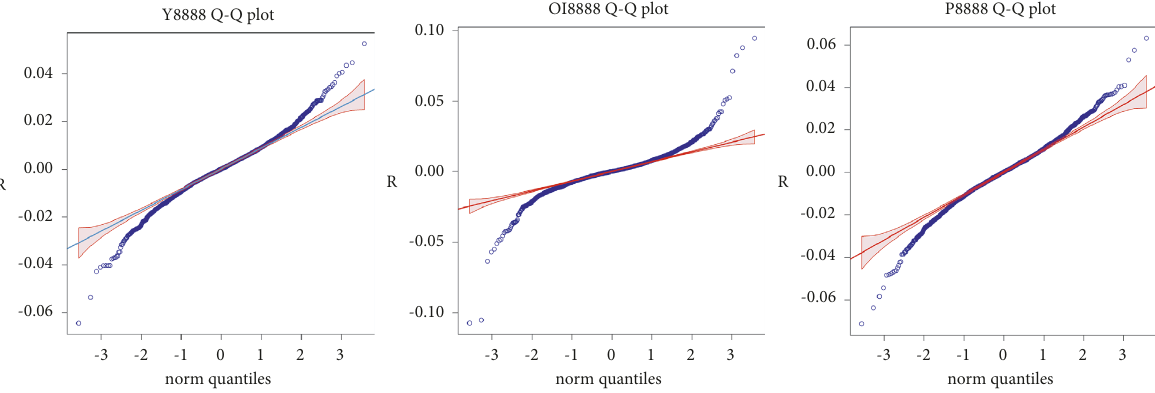
Figure 2: Normal Q-Q plots of daily returns.